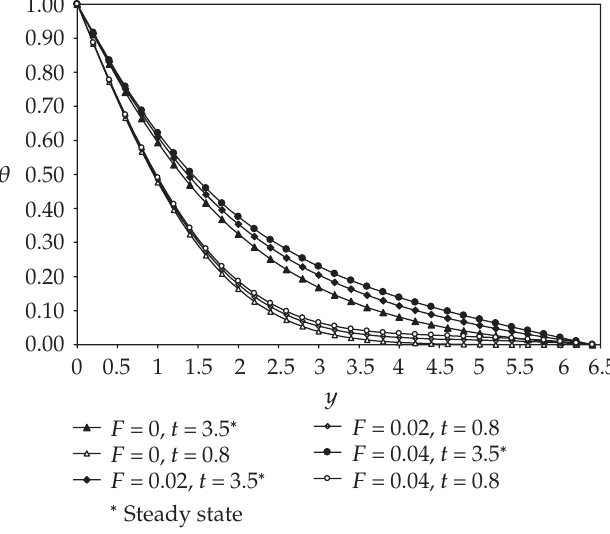
Figure 5.2 . Transient temperature profiles for the di ff erent values of F and for the values x = 1, m = 1, M = 1, and Pr = 0 . 7.